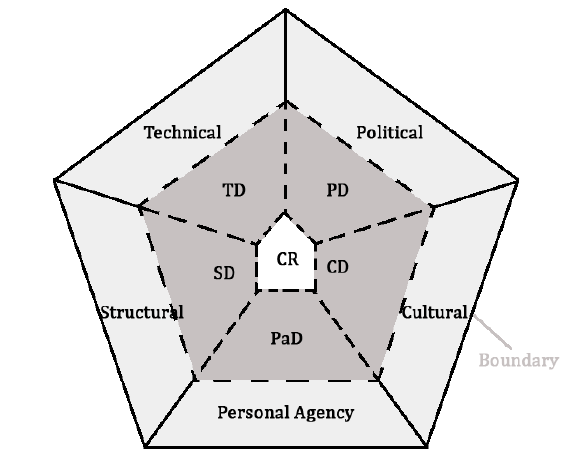
Figure 1 . The web of identity: TD = technical-dramaturgical, PD = political- dramaturgical, SD = structural-dramaturgical, CD = cultural-dramaturgical, PaD = personal agency-dramaturgical, and CR = cognitive resonance (Koole, 2009).